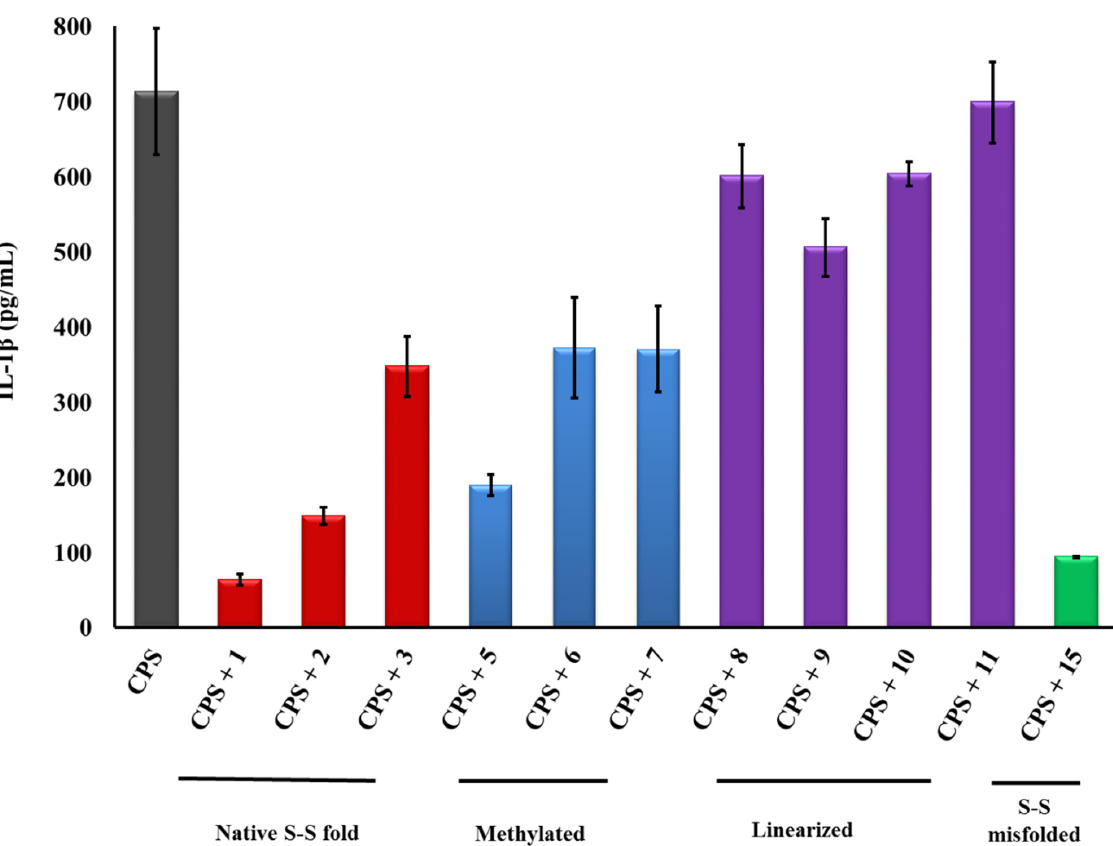
Figure 5. PG-1 analogs neutralized meningococcal capsular polysaccharide (CPS) polymers activity and inhibited IL-1 β release. CPS polymers were purified from the endotoxin-deficient serogroup B meningococcal NMB- lpxA mutant designated CPS. IL-1 β was released from human macrophage-like THP-1 cells induced overnight with meningococcal CPS polymers (25 µg/mL) pre-incubated with or without 2 µg/mL of PG-1 or its derivatives for 30 min at 37 °C. IL-1 β release was measured by ELISA. Error bars represent ±SD from the mean of duplicate measurements. This experiment is representative of two independent